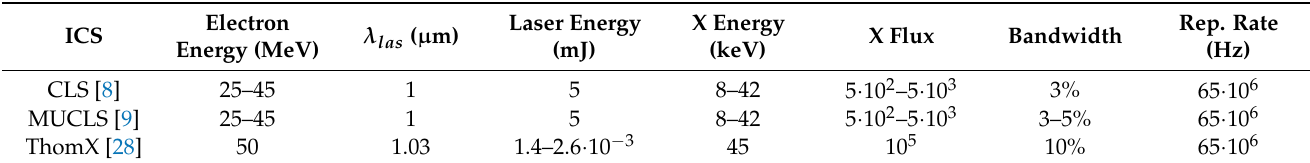
Table 2. Storage ring+ laser in Fabry-Pérot cavity. The data of CLS and MUCLS are measured, the ThomX data are